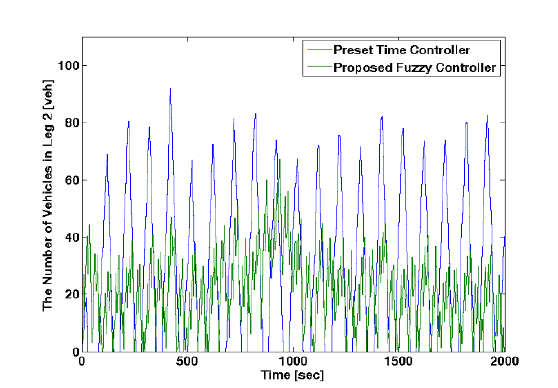
Figure 12. The number of vehicles in Leg2